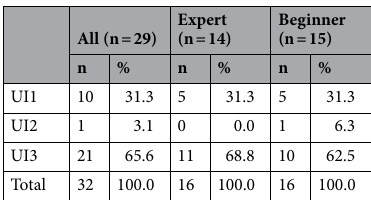
Table 1. Subjective perception of HMI.